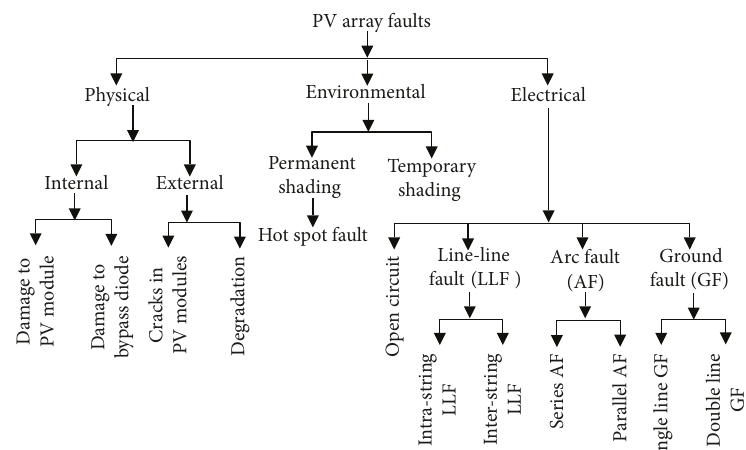
Figure 2: Classi fi cation of PV array faults.